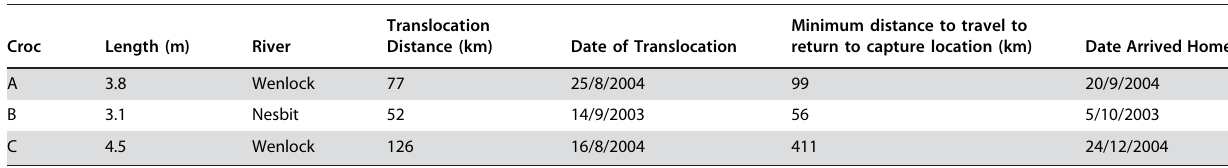
Table 1. Summary of data for translocated, male estuarine crocodiles, Crocodylus porosus .. ... .... ... ... .... ... ... .... ... ... .... ... ... .... ... ... .... ... ... .... ... ... .... ... ... .... ... ... .... ... ... .... ... ... .... ... ... .... ... ... .... ... ... . Croc